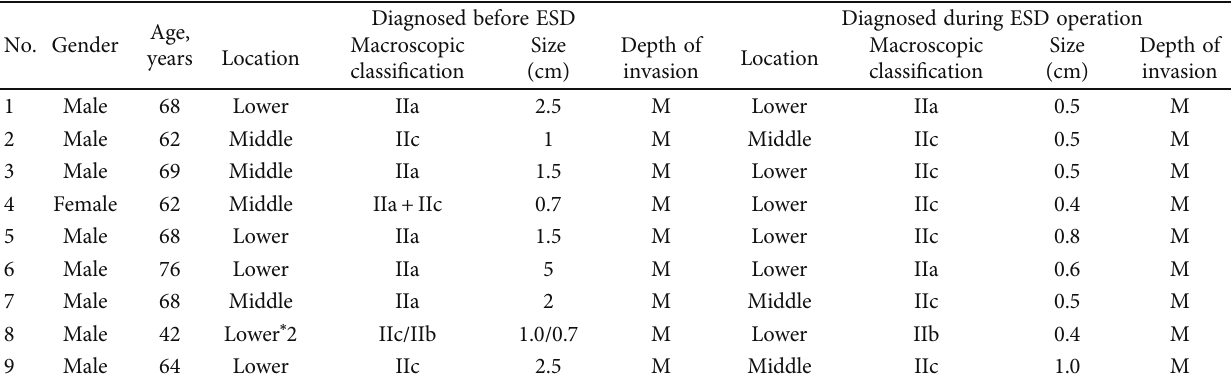
Table 4: SMEGC lesion diagnosed during ESD operation ( n = 9